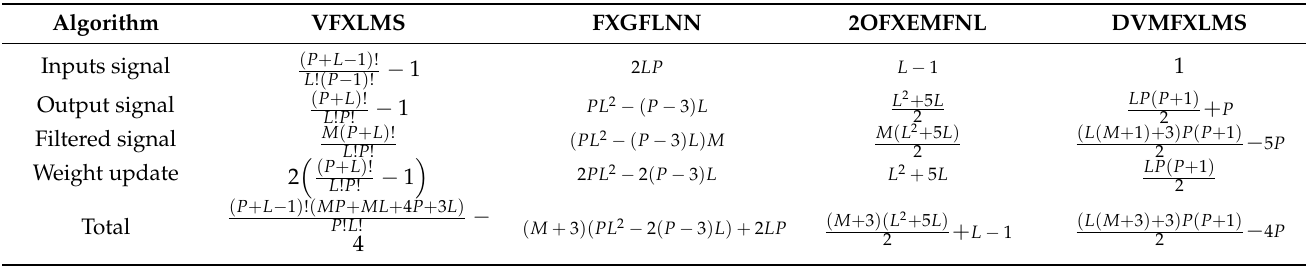
Table 1. Computational complexity of different algorithms for NANC with the NSP using filtered-reference structure.